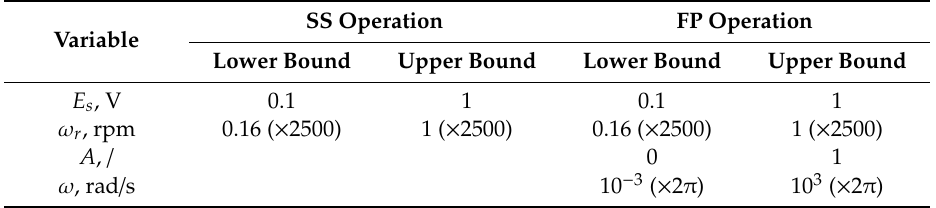
Table 4. Pareto optimization variables for Example 2: ECR and its corresponding lower and upper bounds with scaling values (in